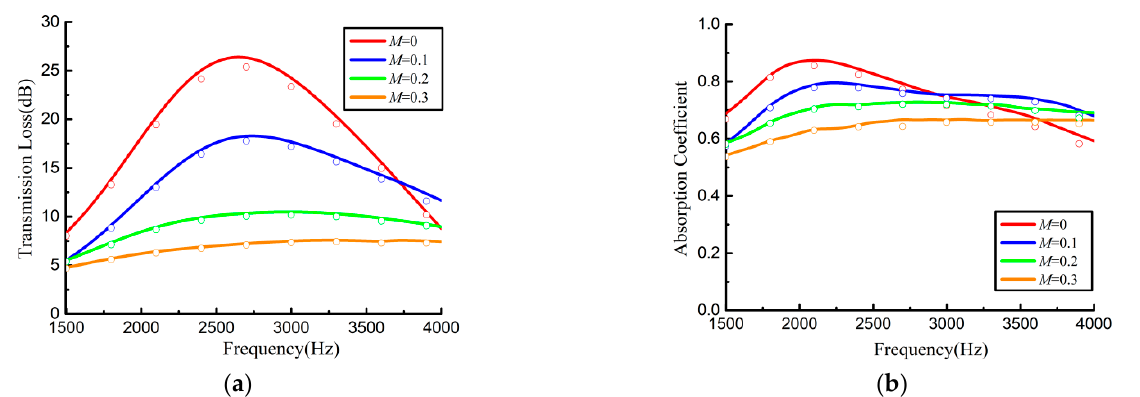
( b ) Figure 23. The geometric and detailed FE models of the ADCAA system with grazing flow (suitable for the IBNSE method). ( a ) Geometric model and ( b ) FE model. It can be seen form Figure 24 that under different Mach numbers, the transmission loss and absorption coefficient obtained by the IBNSE method also agreed very well with those obtained by the FNSE computations. The designed cylindrical acoustic absorber had good absorption performance over a very wide frequency range (absorption coefficient was higher than 50%). The absorption characteristics of the ADCAA system were similar to those of the RDPAA structure. However, the influence of Mach number on the absorp-